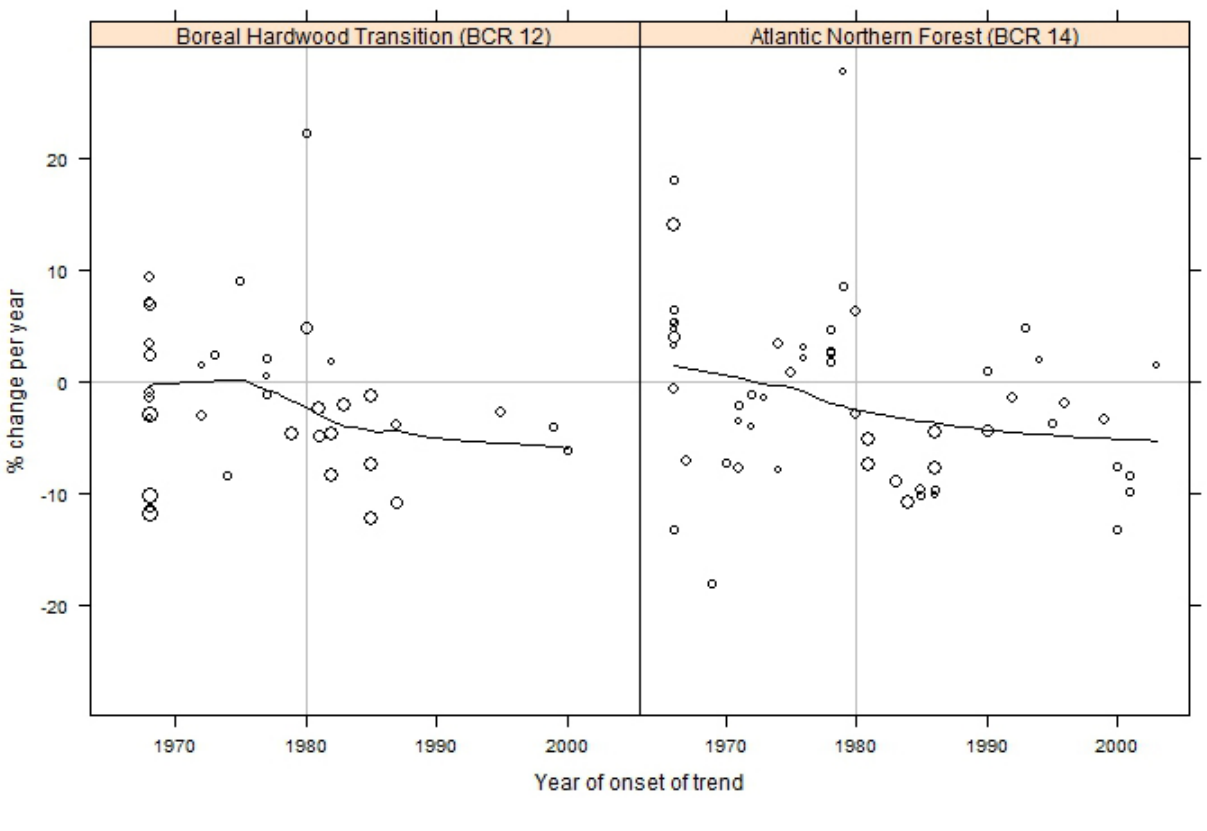
Fig. 4 . Patterns of change across all species of aerial insectivores by year. Prior to 1980, trends show varying patterns, but trends become increasingly negative over time. Circles show the annualized trend between change points (from Figure 3, including the beginning and ending of each time series) plotted by the initial year. The sizes of circles are proportional to the square root of the duration of the trend (so larger circles represent trends over longer time periods). The horizontal (trend = 0) and vertical (year = 1980) lines are provided for reference. Trends are only shown for periods exceeding 4